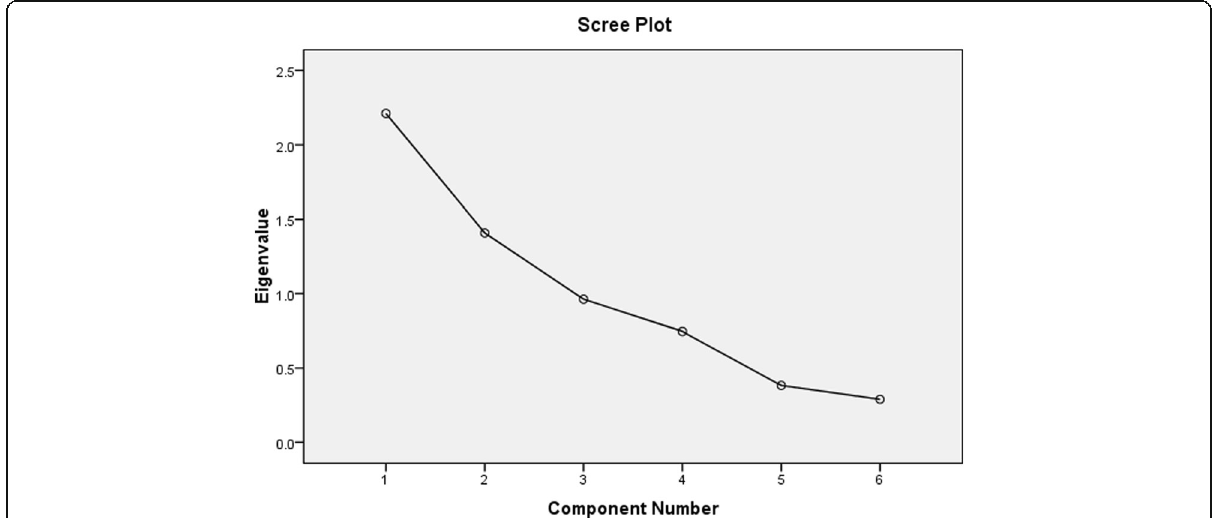
Fig. 10 Scree plot of eigenvalue of principal components for grass